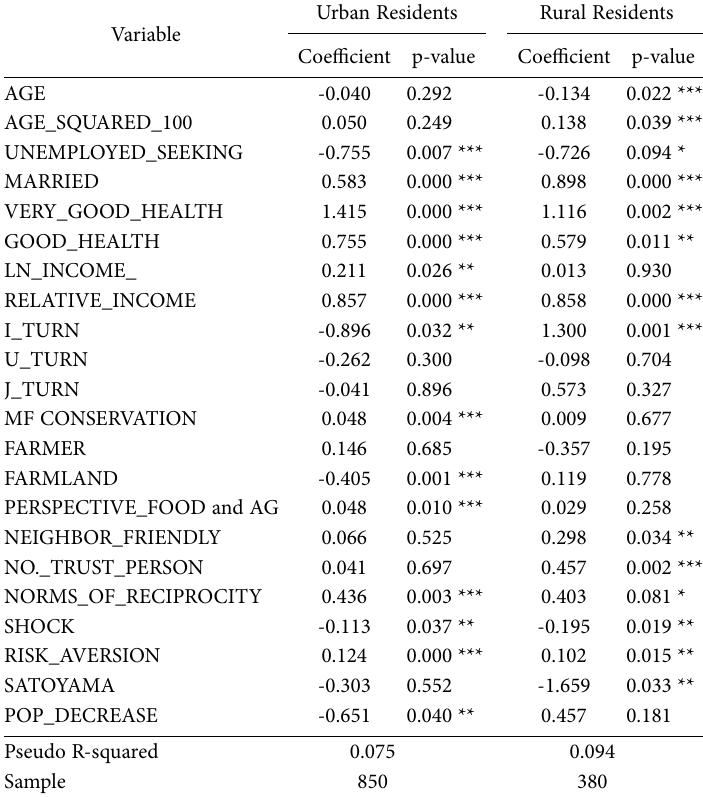
Table 4. Ordered Logit Model results by resident type (Dependent variable: